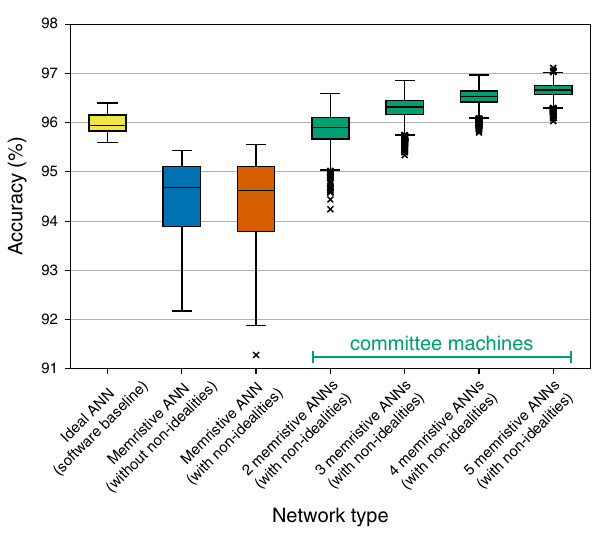
Fig. 9 Effectiveness of committee machines when controlling for the total number of Ta/HfO 2 devices. Median accuracy achieved by individual one- hidden-layer memristor-based networks and their committees. The networks contained 25, 50, 100, or 200 hidden neurons and were disturbed using faulty devices and D2D variability data from Ta/HfO 2 crossbar.